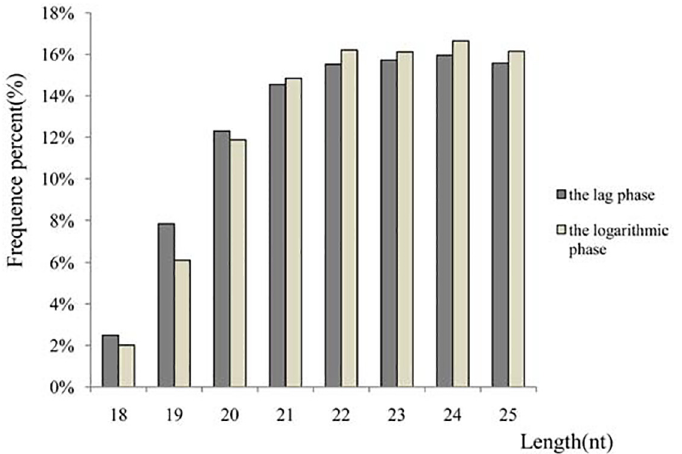
Fig 1. Length distribution and abundance of sequenced small RNA sequences in A . catenella libraries. Among the small RNAs in the range of 18 – 25 nt, the most abundant size was 24 nt, followed by 22 nt and 25 nt.